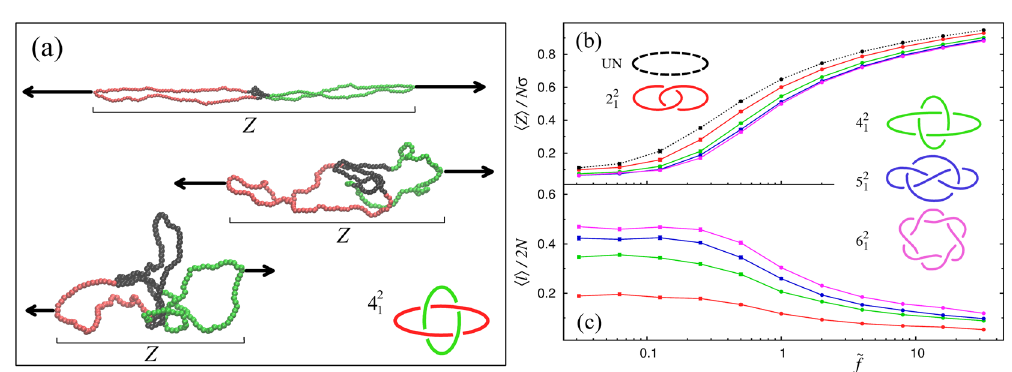
Figure 3. Stretching topologically linked loops: ( a ) Configurations of linked pairs of loops (Solomon link) in canonical equilibrium at temperature T at three values of the stretching force, f . Each loop is modelled as a semiflexible ring of N = 120 beads and persistence length lp = 5 σ where σ is the bead diameter. The linked portions are highligted in black and Z is the span projected in the stretching direction, which cannot be larger than half the total contour length, N . ( b ) Average normalized span, 〈 Z 〉 / N σ , as a function of the reduced force σ =  f f k T / . The solid curves refer to different link types (see labels) while the dashed one is for a single loop B twice longer (2 N = 240). ( c ) Force dependence of the average contour length of the linked portions for the linked loops of ( b